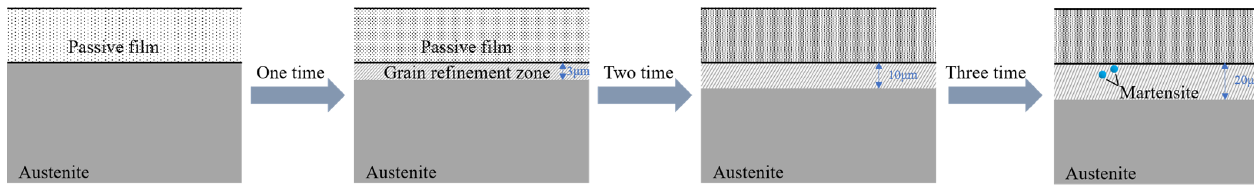
Figure 12. Schematic diagram of laser shock treatment applied to the welded area of the 316L stainless steel samples.